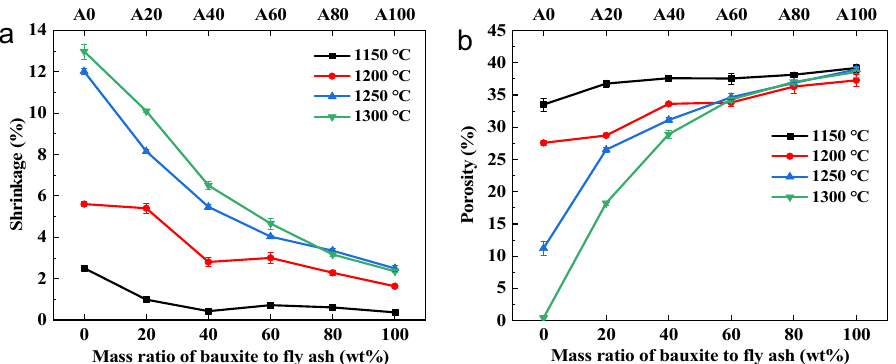
Figure 5. Shrinkage ( a ) and porosity ( b ) of fly ash supports obtained by sintering at different temperatures with different amounts of bauxite.